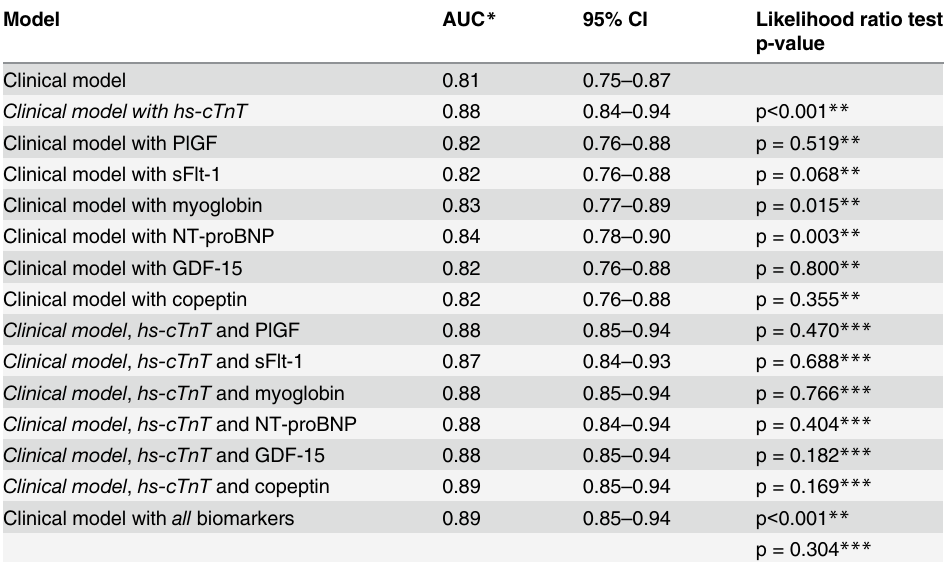
Table 7. Multivariable analysis including patients within 3 hours of symptom onset (n =